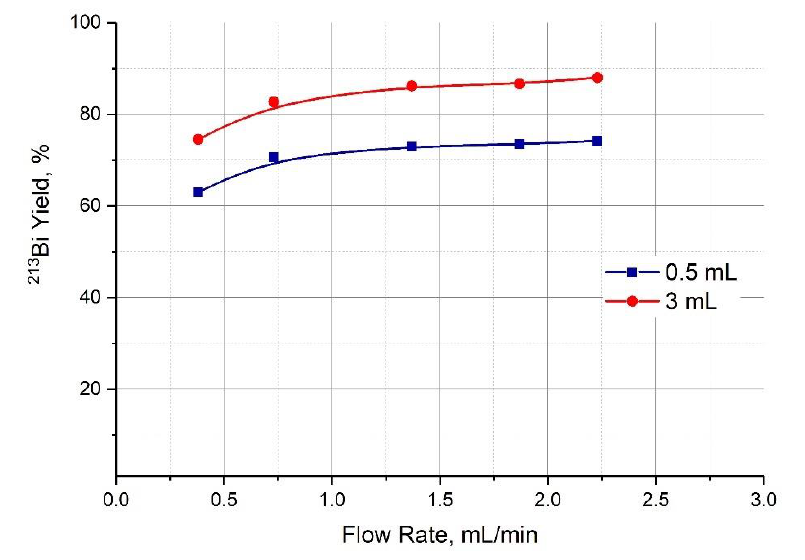
Figure 7. The elution efficiency of the generator “Afrabis” depending on the flow rate of the eluent (0.25 М HNO 3 ) during circulation. The values for the first portion of eluate (0.5 mL) and for the whole fraction (3 mL) are given.